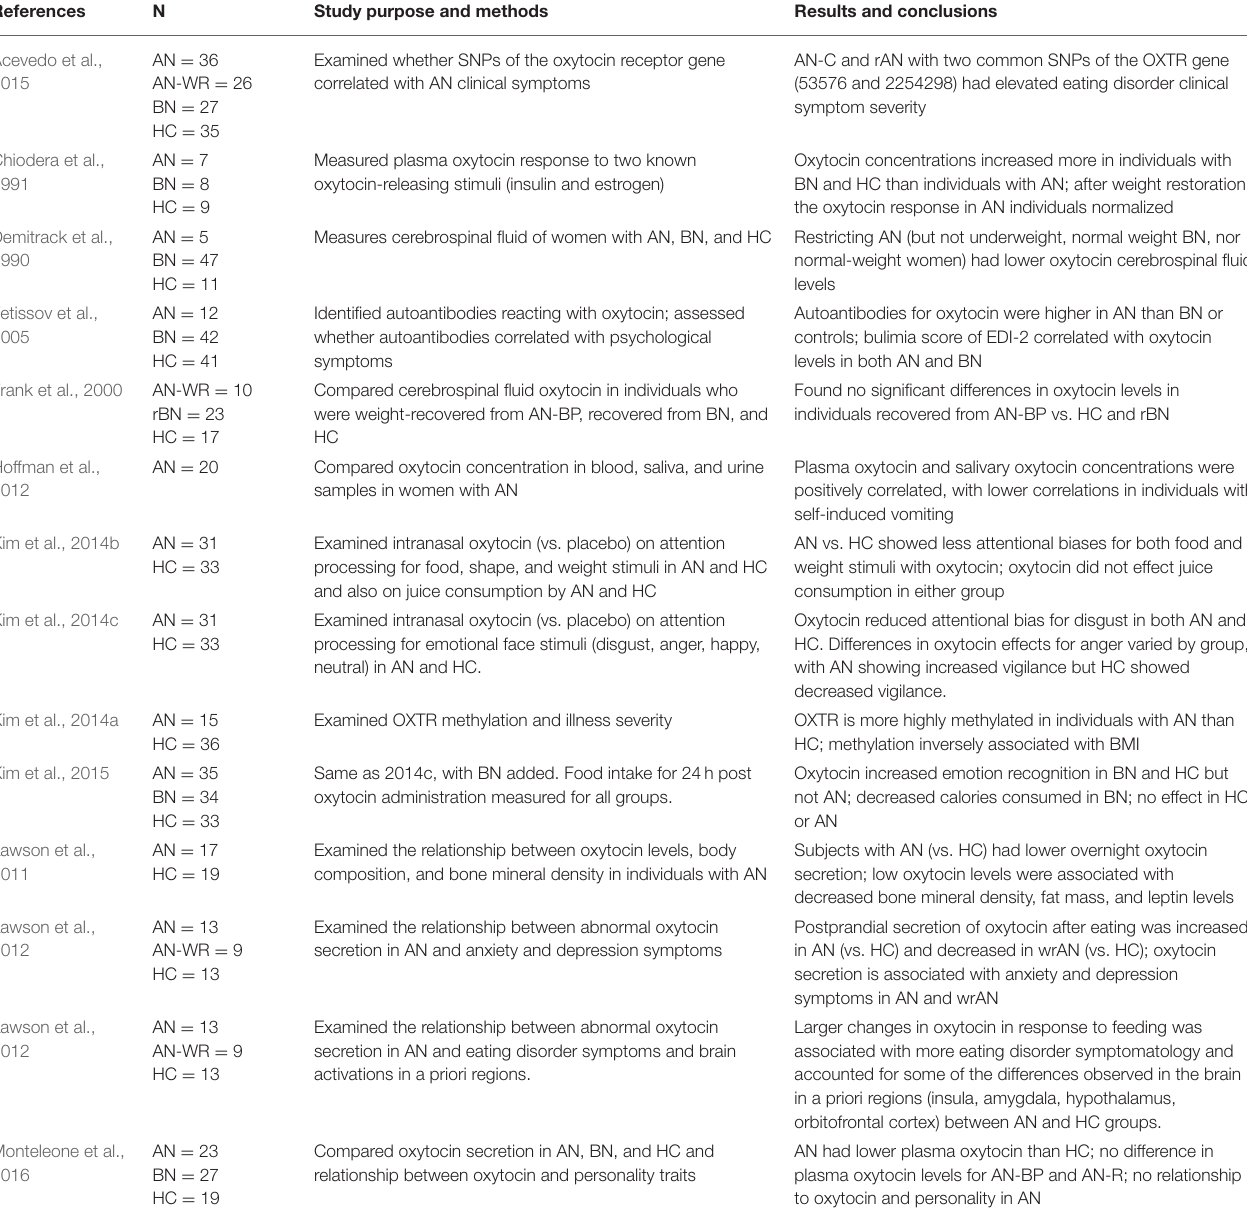
TABLE 3 | Studies examining oxytocin in anorexia